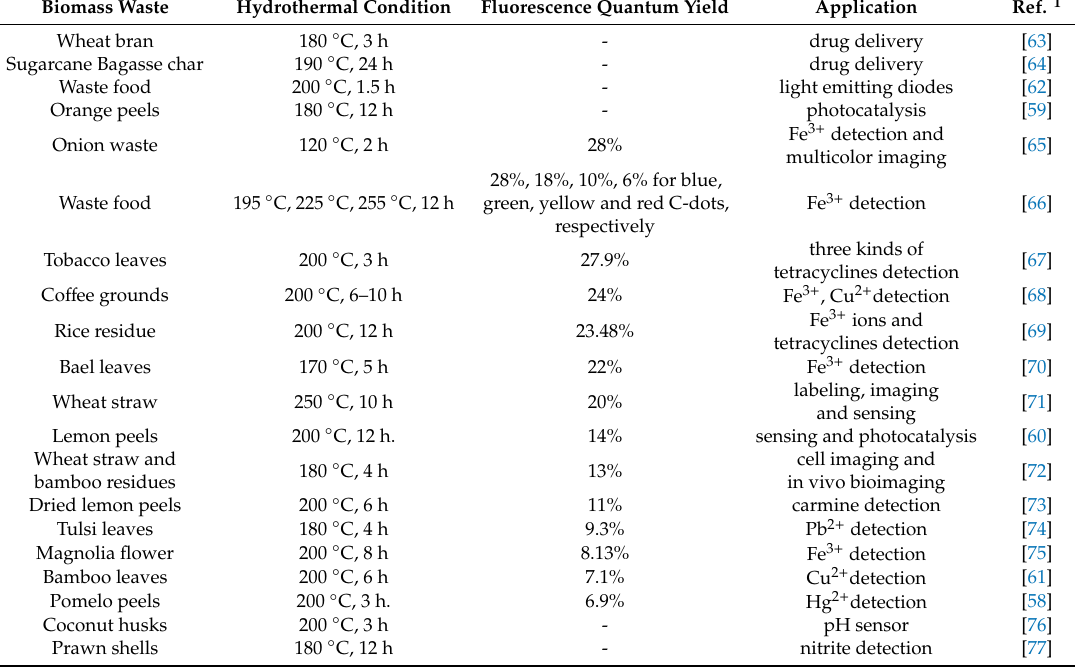
Table 1. The properties and applications of C-dots produced from di ff erent biomass waste by solvothermal